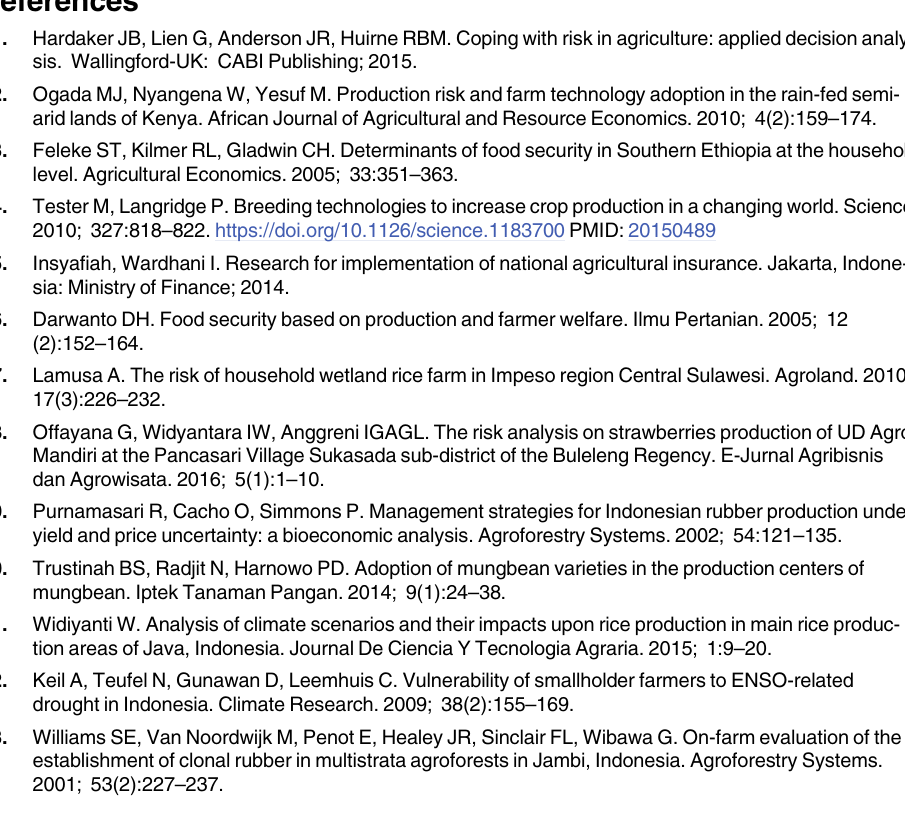
S1 Table. Data of